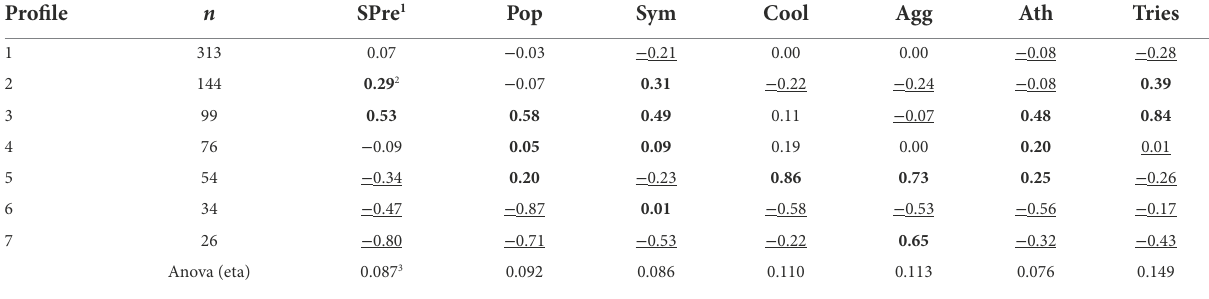
TABLE 5 Mean social status descriptors by profile.